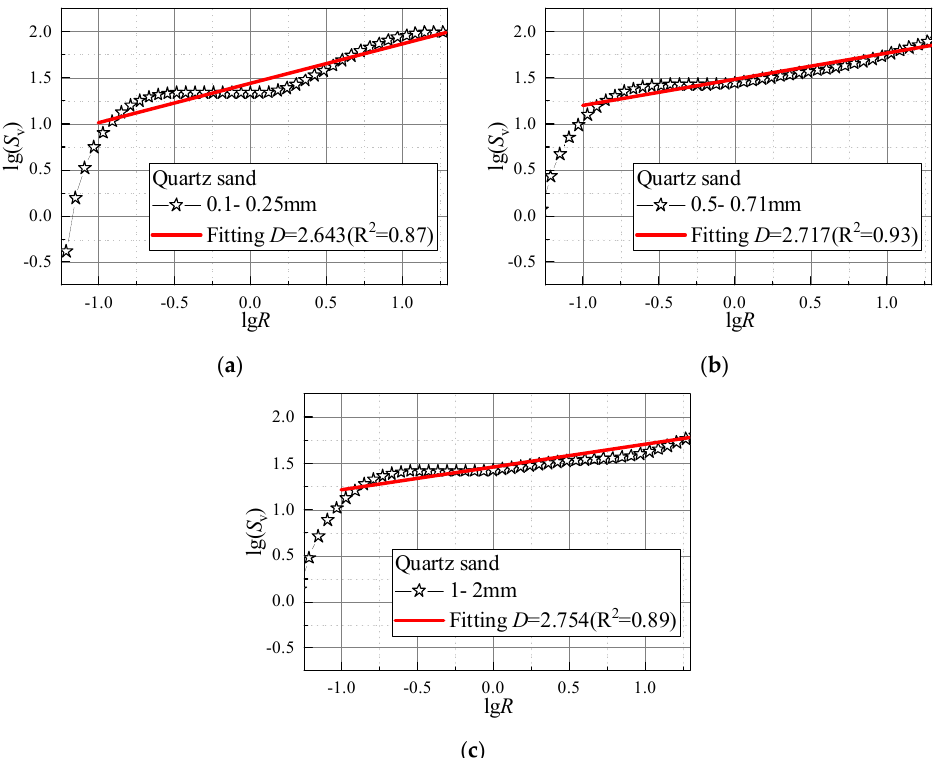
Figure 9. Determination of fractal dimension of quartz sand with different grain sizes: ( a ) 0.1–0.25 mm; ( b ) 0.5–0.71 mm; ( c ) 1–2 mm. Figure 11 shows the relationship between the fractal dimension and the mean grain size ( d 50 ) of the three sands. It can be clearly observed that the fractal dimensions of cal- careous sand and quartz sand all increase significantly with the increase of grain size. Compared with calcareous sand and quartz sand, the fractal dimension of glass beads increases more slowly with grain size. This may be due to the single shape (i.e., round shape) of glass beads. Previous studies pointed that the higher fractal dimension of pore size distribution means a more complex pore structure distribution and a stronger heter- ogeneity of the pore structure distribution [29]. The increase of grain size can lead to a significant increase of D for calcareous sand, quartz sand and glass bead. This indicates that the increase of grain size can cause a more complex pore structure distribution in the sand. Furthermore, under the same grain size, the fractal dimension of calcareous sand is the smallest, the fractal dimension of glass beads is the largest, and quartz sand is some- where in between. In addition, the fractal dimension of calcareous sand increases more slowly with grain size than quartz sand. The larger the grain size, the greater the gap between the fractal dimensions of the two sands. This indicates that as the grain size in- creases, the difference in particle shape has a more obvious impact on the pore structure.